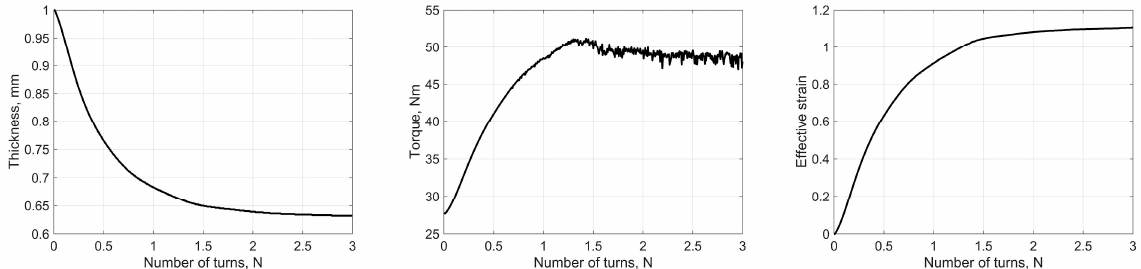
Figure 7. The results of the second set of numerical experiments for m = 0.9. The axial force was increased up to ∆𝑃 = 15 kN and was fixed thereafter. Slippage of the entire specimen (without deformation) set in after approximately two full rotations.